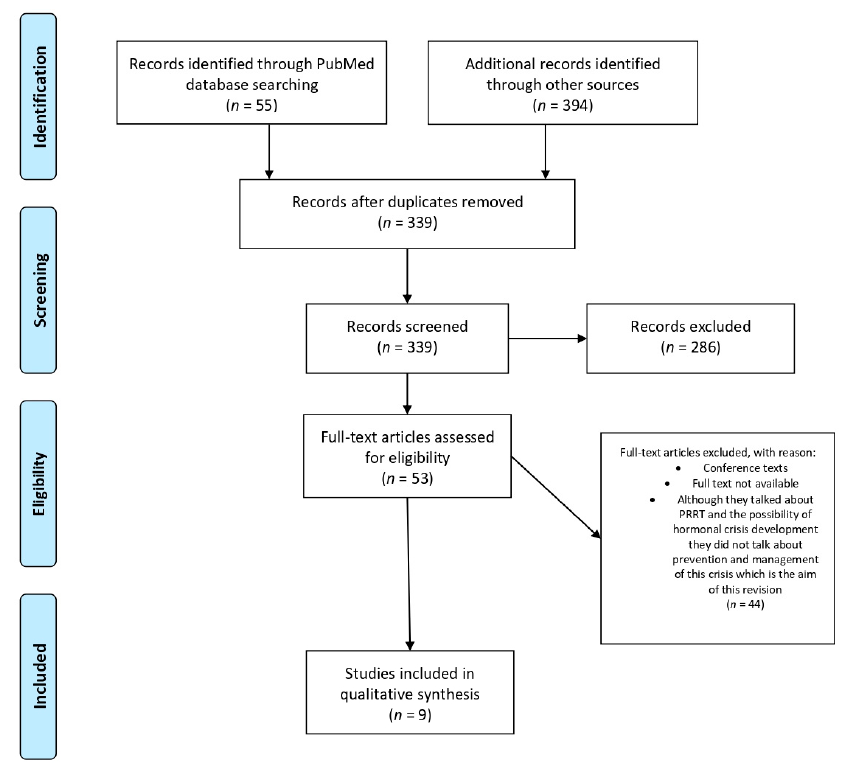
Figure 3. PRISMA flow diagram for studies retrieved through the searching and selection